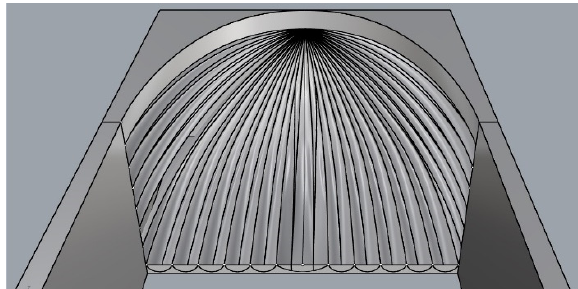
Figure 11. HBIM model of Castle of Maredolce.